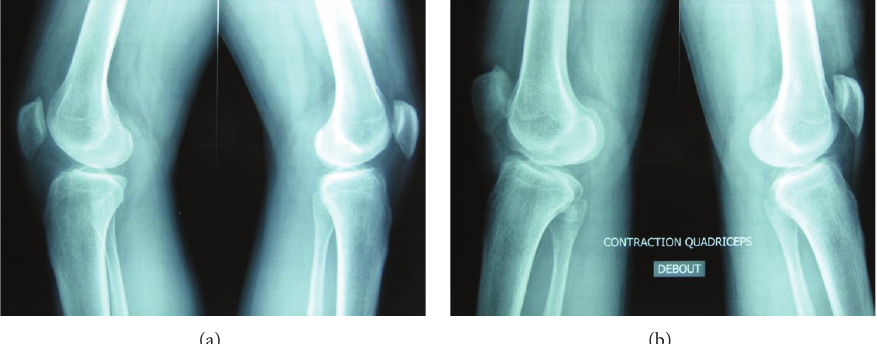
Figure 2: Comparative weight-bearing X-ray lateral view: (a) without contraction of the quadriceps and (b) with contraction of the